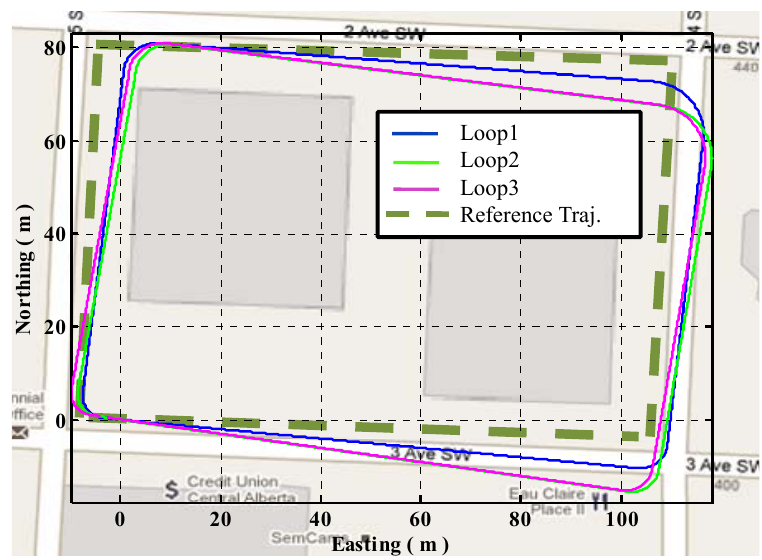
Figure 16. Continuous trajectory in urban canyon using